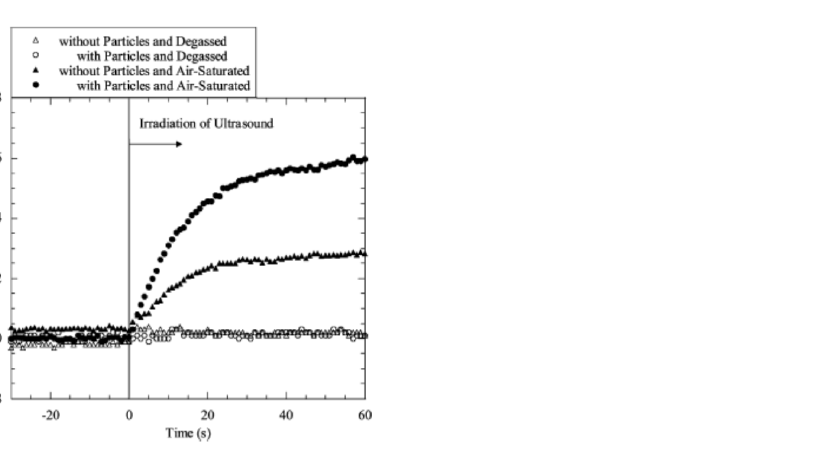
Figure 4. Liquid temperature as a function of time with and without alumina particles of 10 µ m in diameter in air-saturated or degassed water irradiated with ultrasound of 42 kHz. Reprinted with permission from Ref. [96]. Copyright 2005, the American Chemical Society.